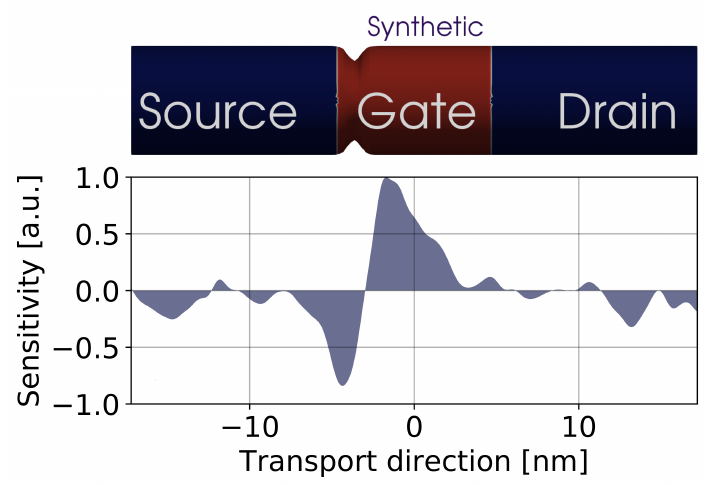
Figure 6. ( Top ) Schematic of a 10 nm gate length GAA-NW FET affected by a localised LER deformation. ( Bottom ) 1D on-current FSM generated from the simulation of 100 localised LER profiles swept along the device channel at a 0.7 V drain